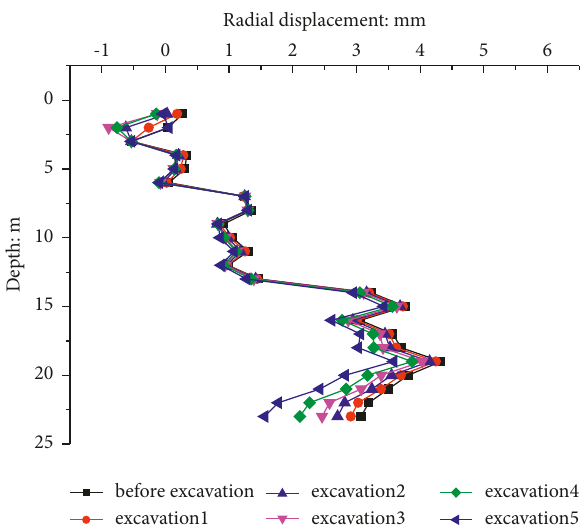
Figure 31: The horizontal displacement of # 1 measuring point changes with depth.